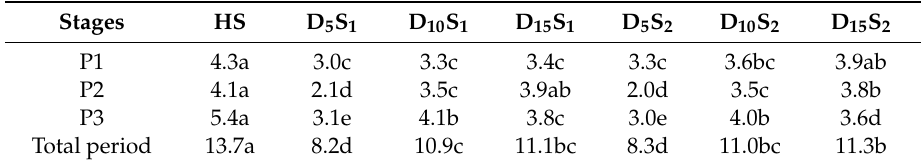
Table 2. Soil evaporation in homogeneous and sand-layered soil columns in different freeze–thaw stages (unit: mm).